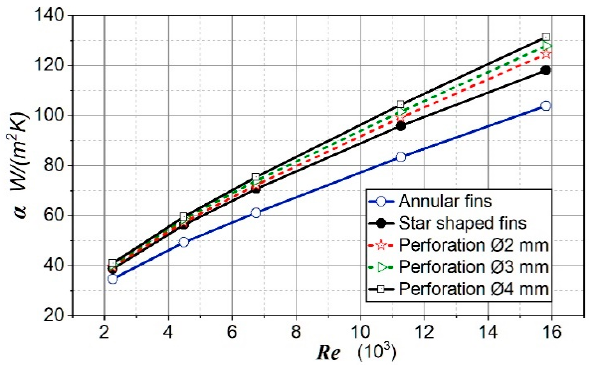
Figure 11. Heat transfer coefficient for analyzed cases.